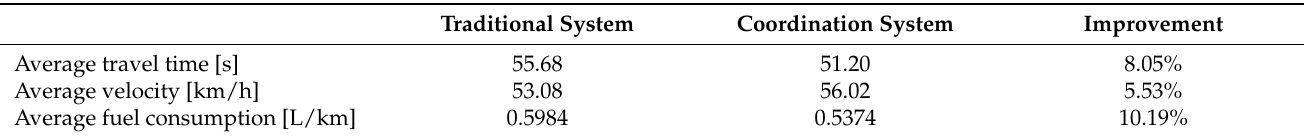
Table 1. Performance comparison between the proposed traffic coordination system and the tradi- tional driving